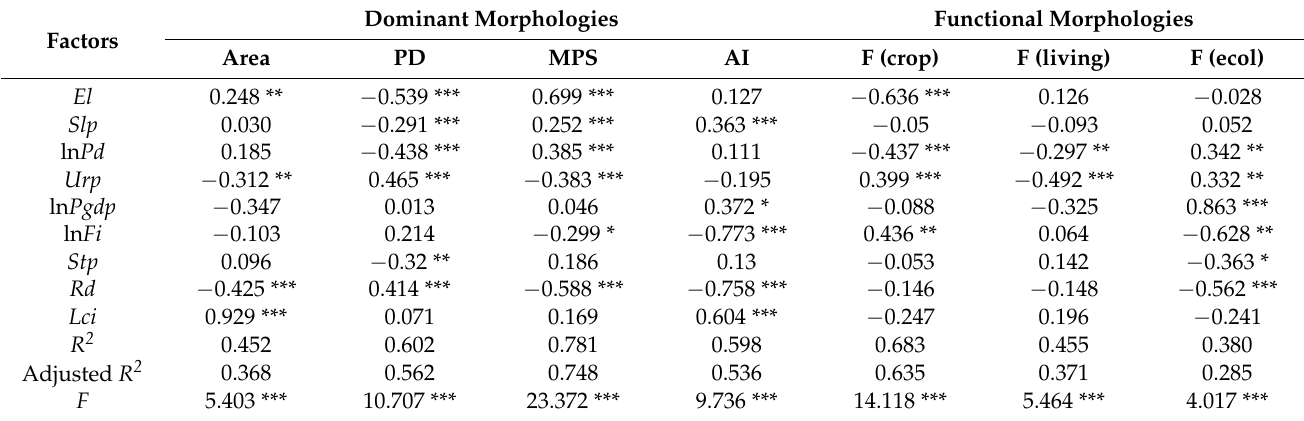
Table 3. The regression analysis results for the morphology of farmland and the driving factors in Sihong in 2009, 2013, and